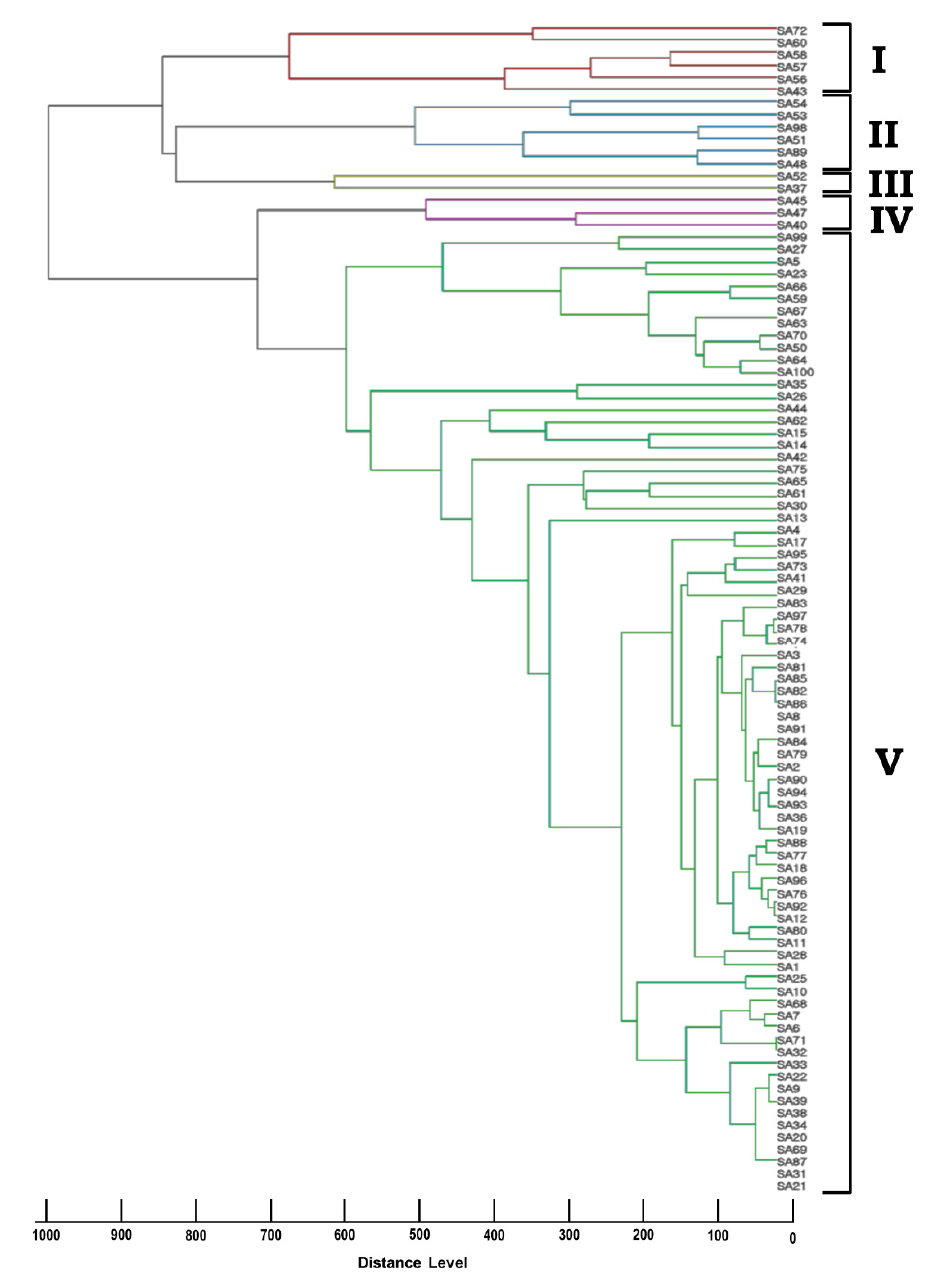
Figure 2. Cluster analysis of the MSP dendrograms generated by the MALDI Biotyper 3.0 for S. aureus isolates. The MSP dendrogram results are clustered as groups (I to V) based on their distance levels. The distance level in the dendrogram was set at a maximal value of 1000.